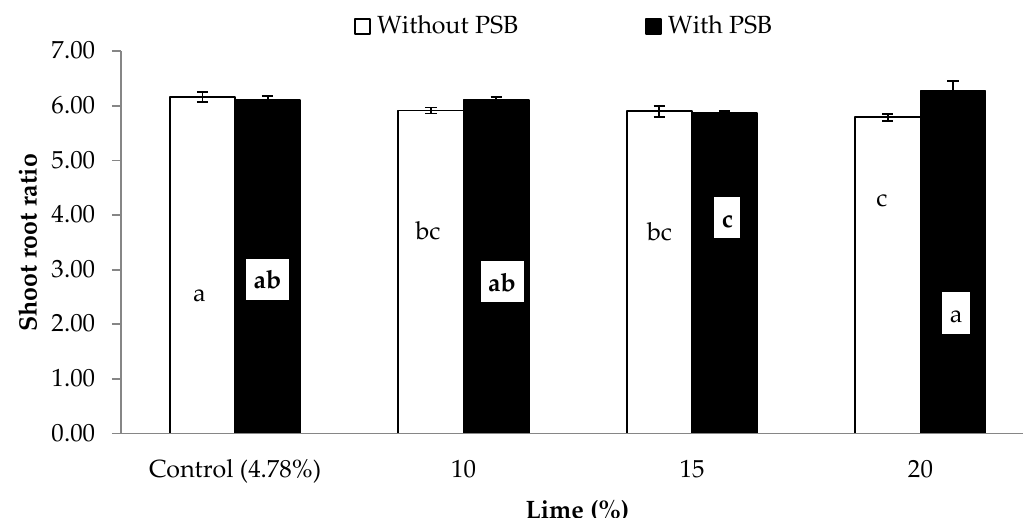
Figure 3. Effect of PSB on shoot root ratio of maize under varying levels of lime. Bars sharing letters are statistically comparable at p < 0.05 according to least significance difference (LSD) test. Error bars show standard error (n = 3).